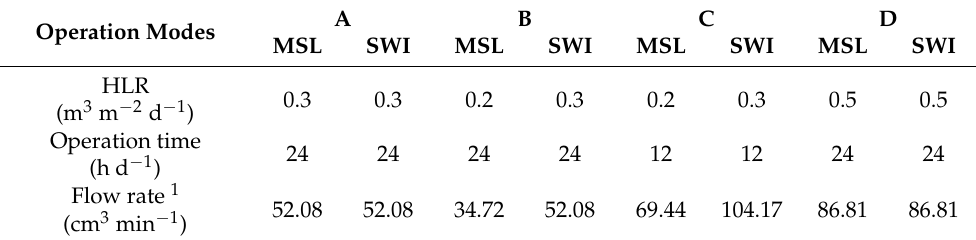
Table 1. Operating parameters of four MSL-SWI systems operated under different modes.